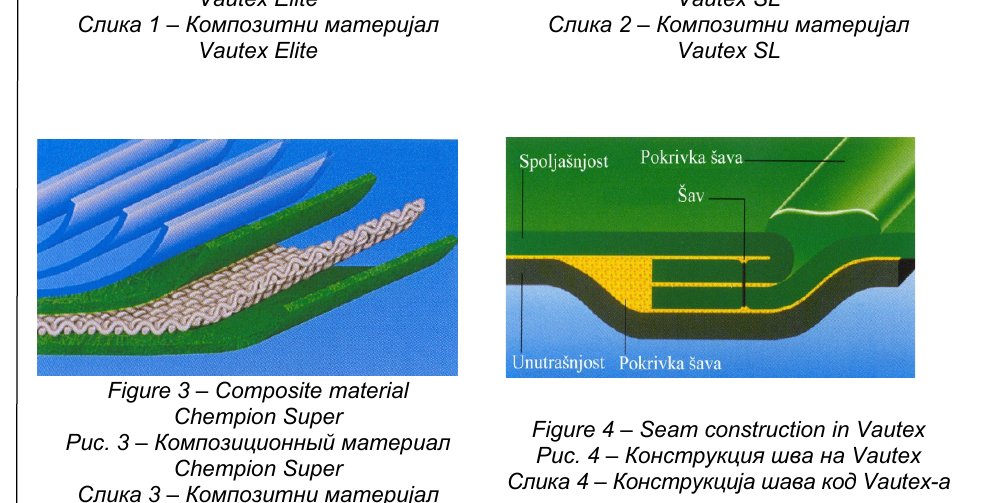
Figure 3 – Composite material